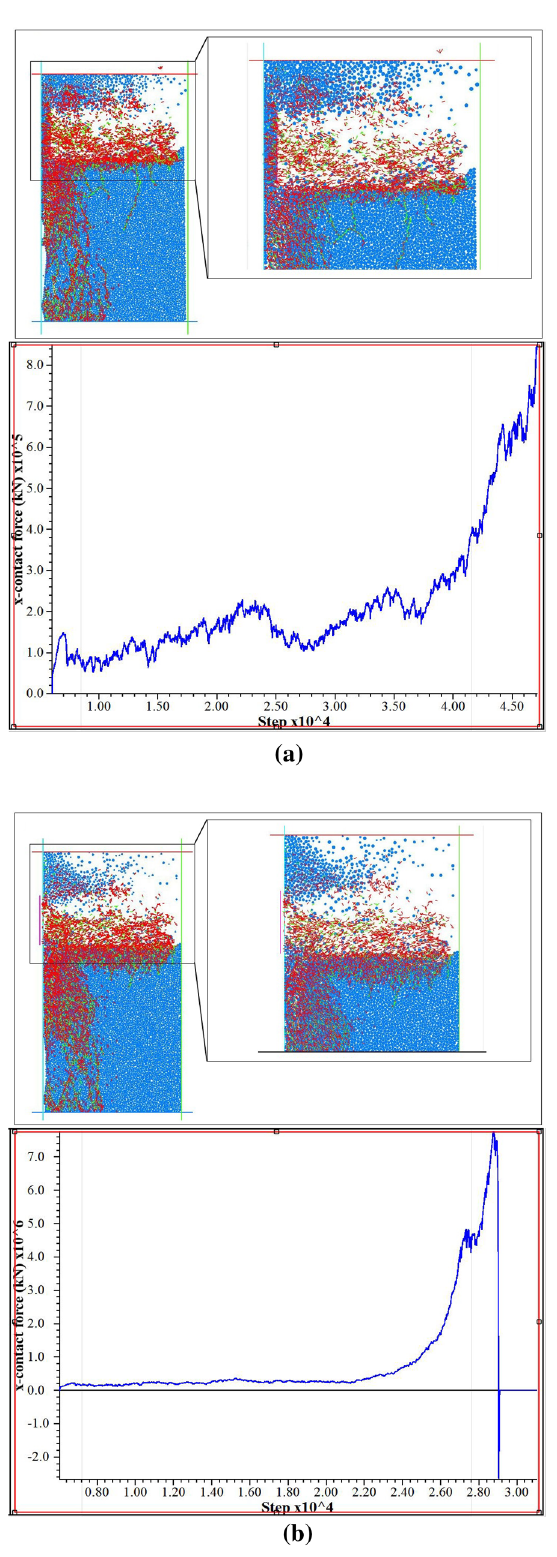
Fig. 19 Results of plow model with zero-degree angle: a Model 25, b Model 26